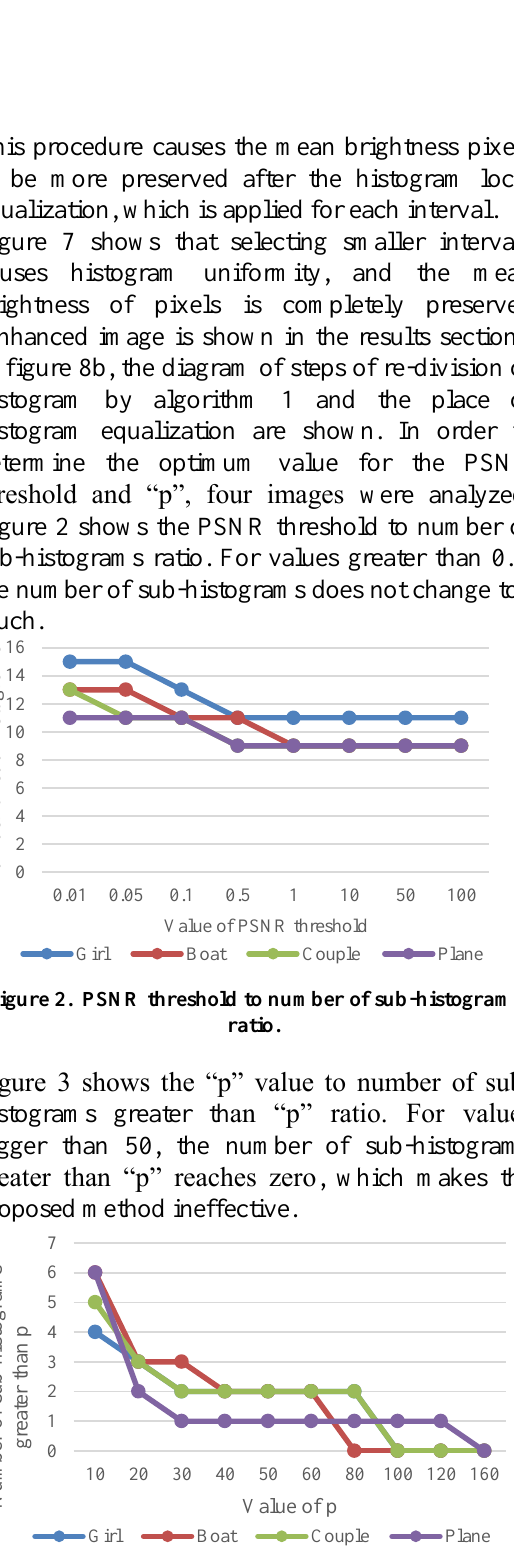
Figure 3. Value of “p” to number of sub-histogram greater than “p”